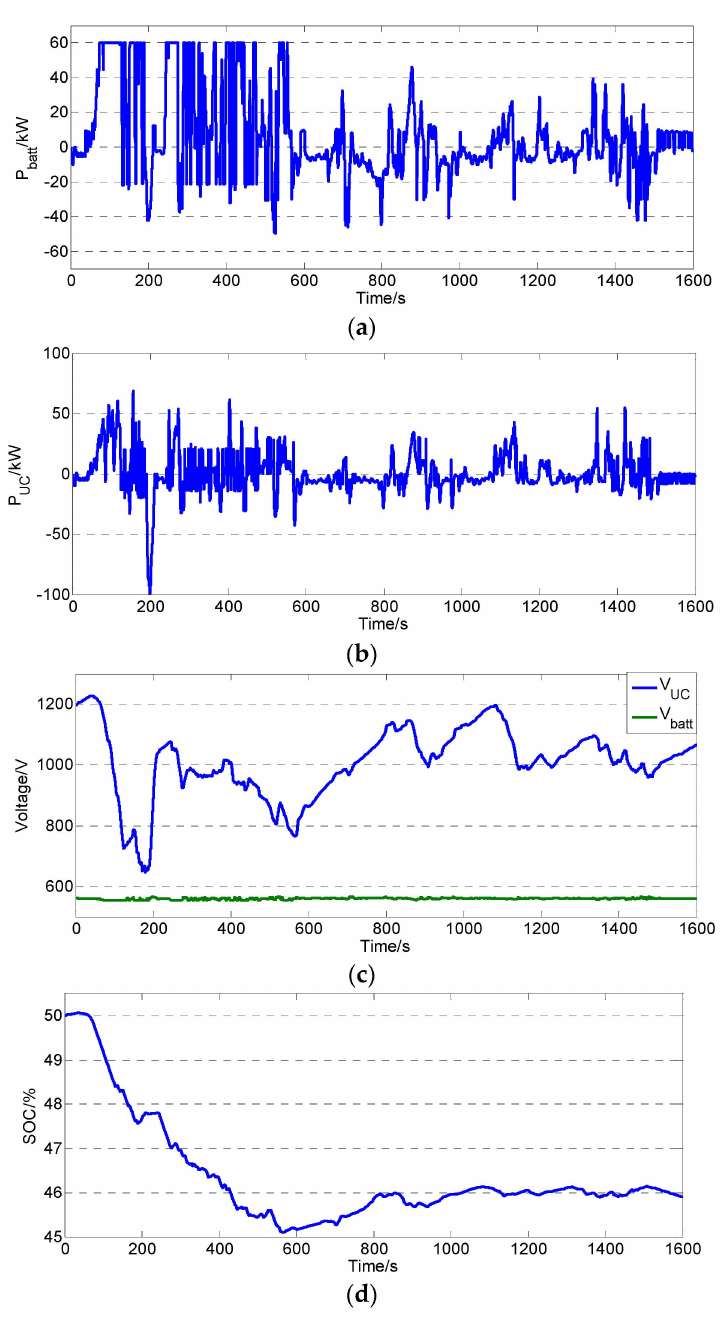
Figure 24. Simulation results of the proposed power management strategy: ( a ) Power of the battery bank; ( b ) Power of the UC bank; ( c ) Voltage of the battery bank and UC bank; ( d ) SOC of the battery